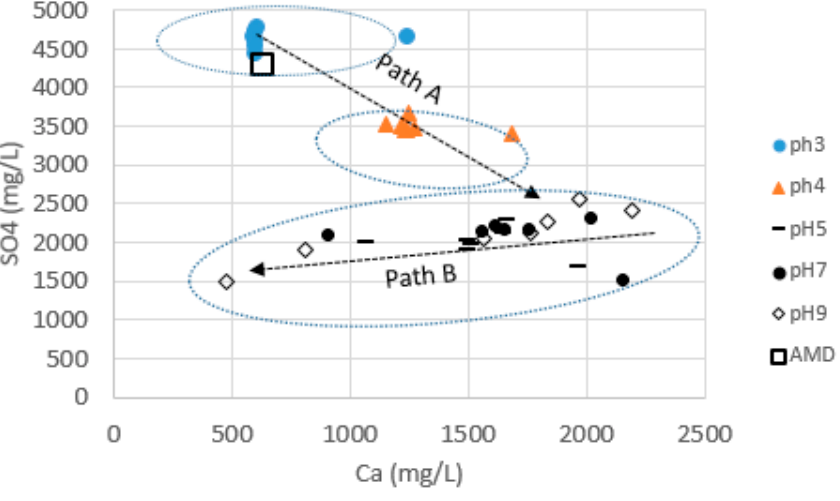
Figure 6. Changes in concentrations of Ca 2+ and SO 42 − versus the pH level over 24 h.